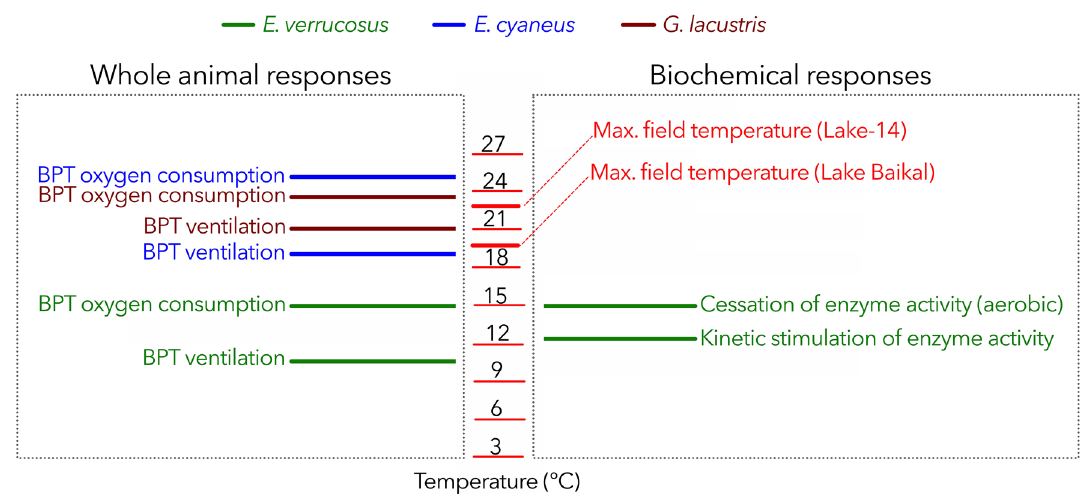
Figure 5. Summary of physiological responses at the whole animal and the biochemical level. Breakpoints (BPTs) indicate limitations/changes of physiological processes in E. verrucosus (stenothermal, Lake Baikal endemic), E. cyaneus (eurythermal, Lake Baikal endemic), and G. lacustris (eurythermal, Holarctic ubiquitous) determined in thermal increase experiments (0.8 °C per day, start temperature: 6 °C). In the two eurythermal species, E. cyaneus and G. lacustris, no breakpoints of biochemical measures (i.e., capacities of key metabolic enzymes) were determined in the studied thermal range (6–23.6 °C). In the stenothermal E. verrucosus , the BPT of routine metabolic rate (measured as oxygen consumption) correlates with the cessation of activities of key metabolic enzymes that rely on molecular oxygen